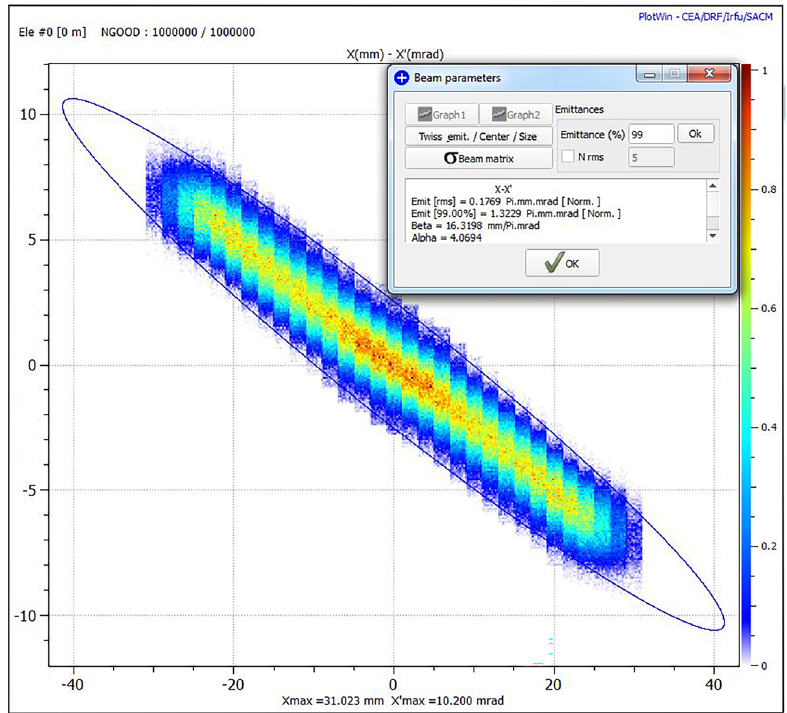
Figure 12. Beam emittance measurement of the beam produced with one of the most representative HSMDIS configurations (picture generated with